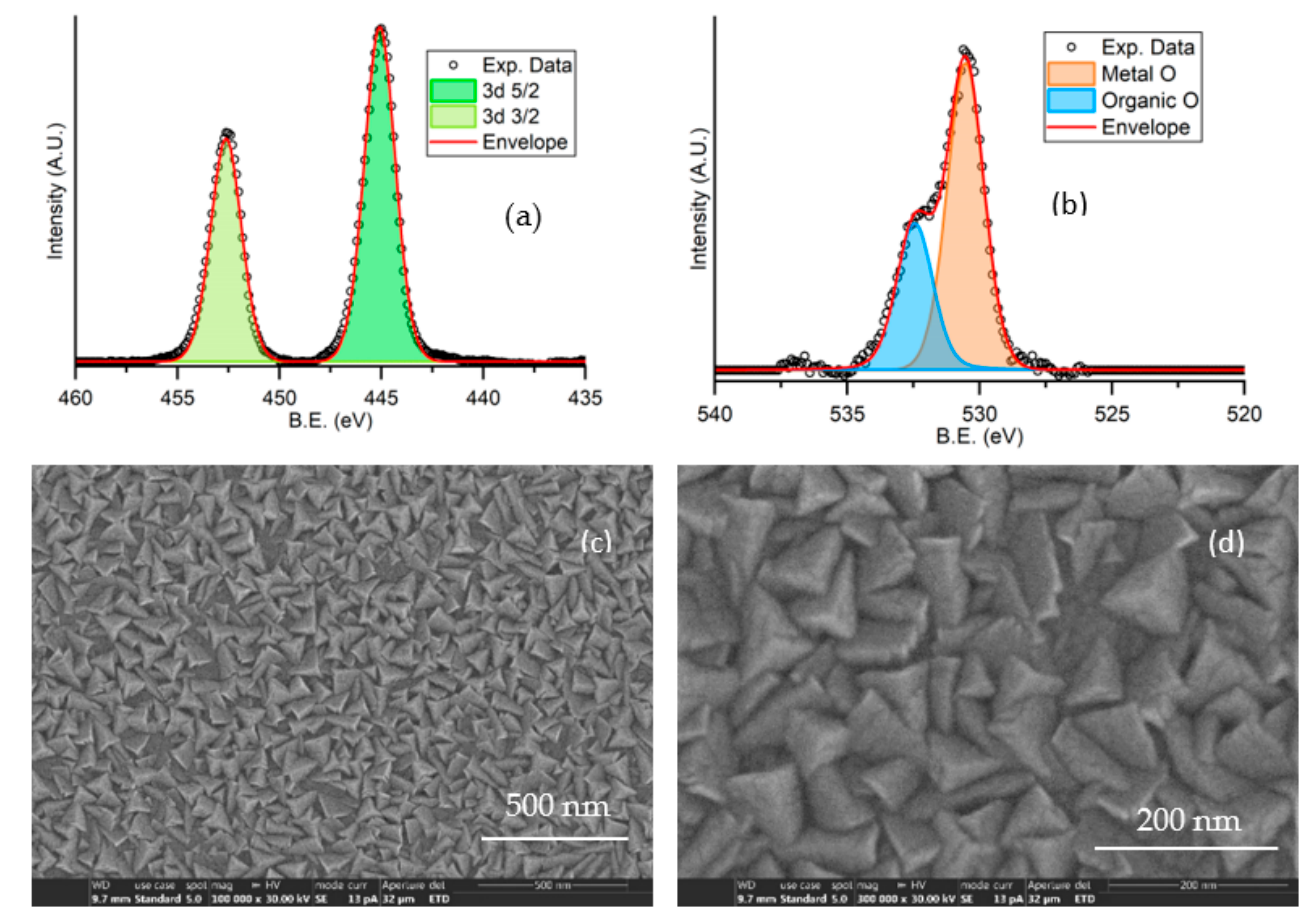
Figure 2. Characterization of an In 2 O 3 − x 500 nm thick film deposited on a glass substrate: XPS spectra showing peaks for indium ( a ) and oxygen ( b ); SEM analysis at 10 5 ( c ) and 3 × 10 5 ( d ) magnification.